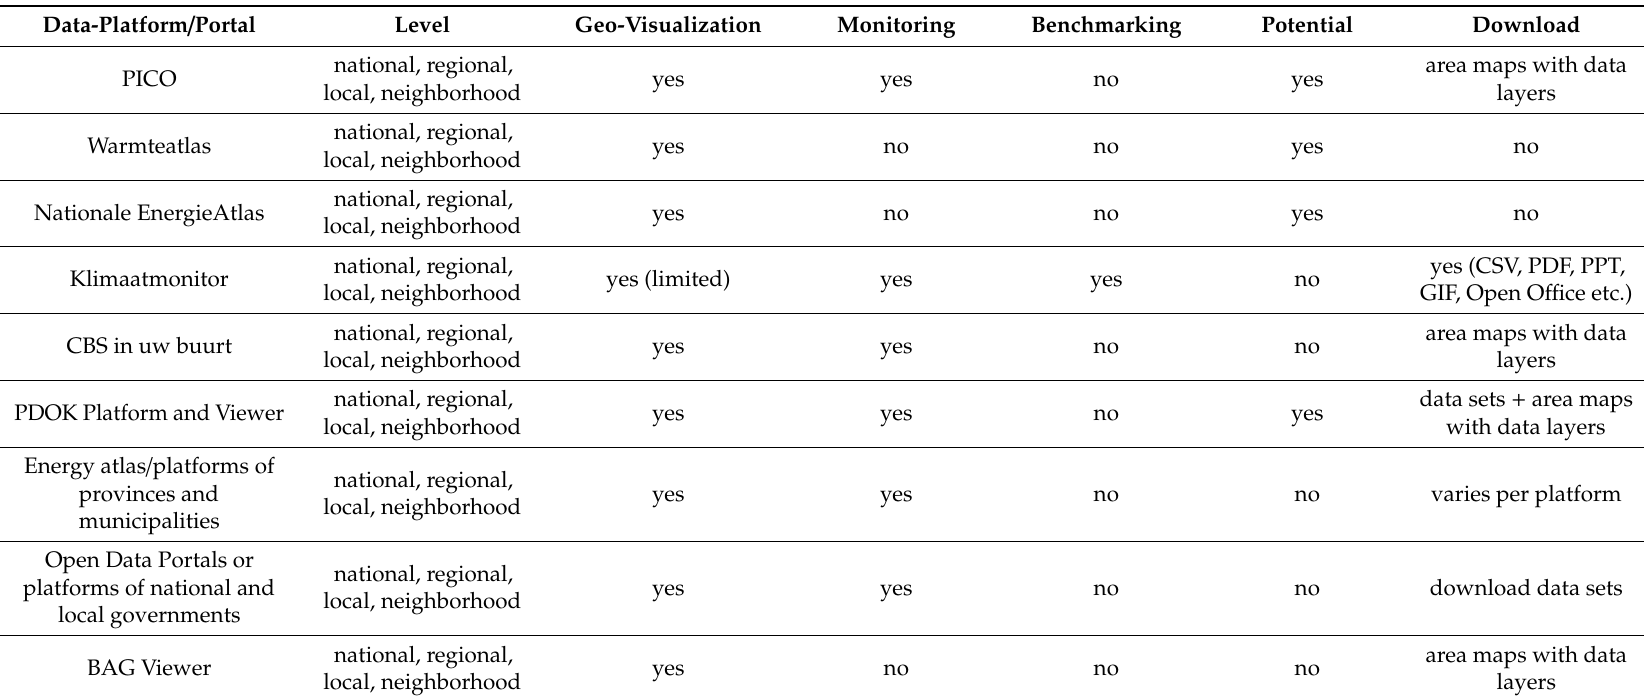
Table A4. Overview of the data platform or portal